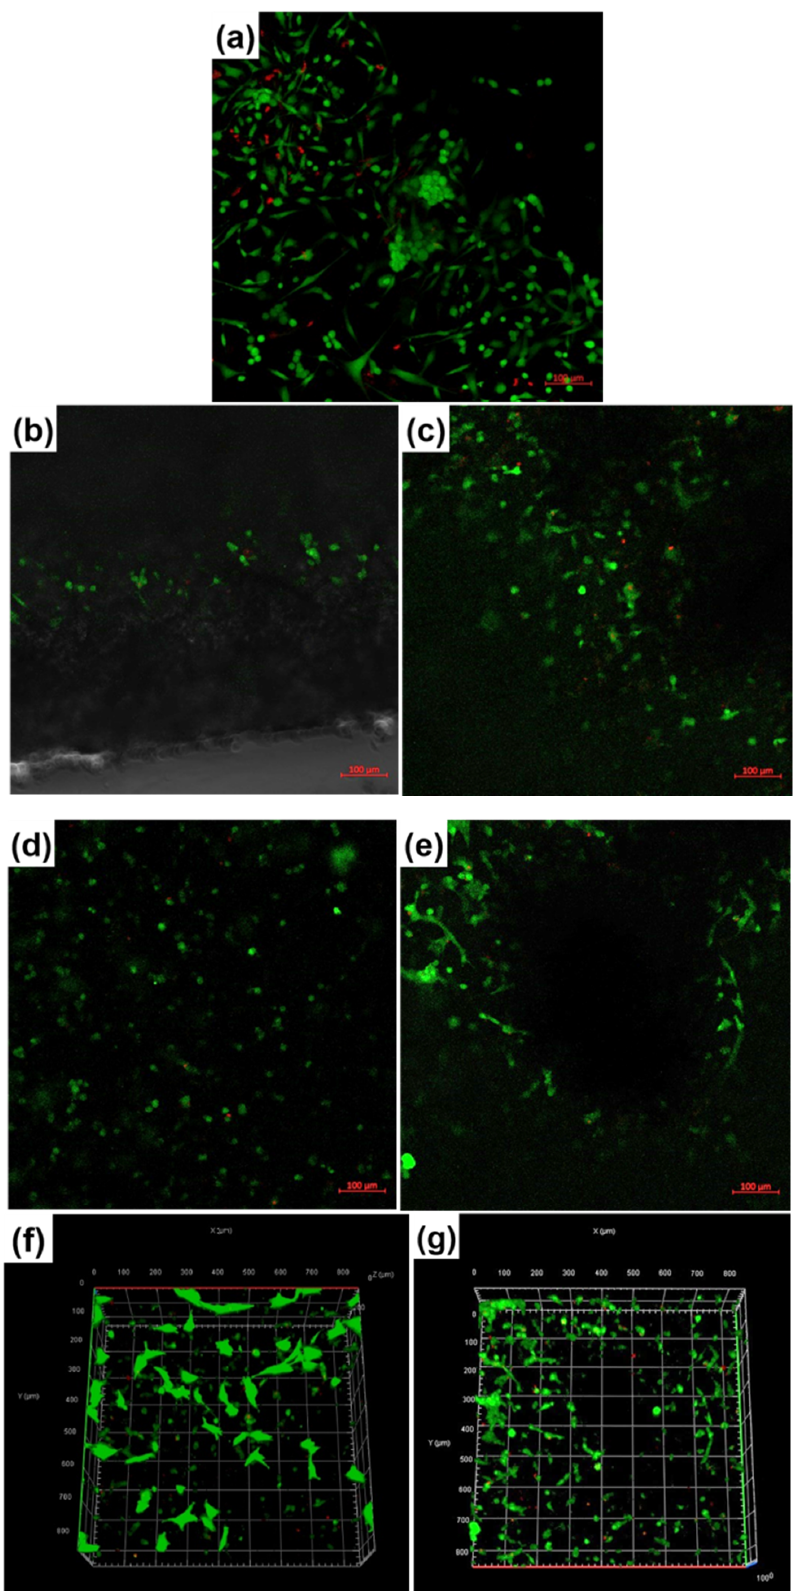
Figure 6. ( a ) Fluorescence microscopy images recorded on fetal osteoblasts cultured for 24 h of: ( a ) Control, ( b ) PCL-Mg-1, ( c , f ) PCL-Mg-5, ( d ) PCL-Sr-1 and ( e , g ) PCL-Sr-5